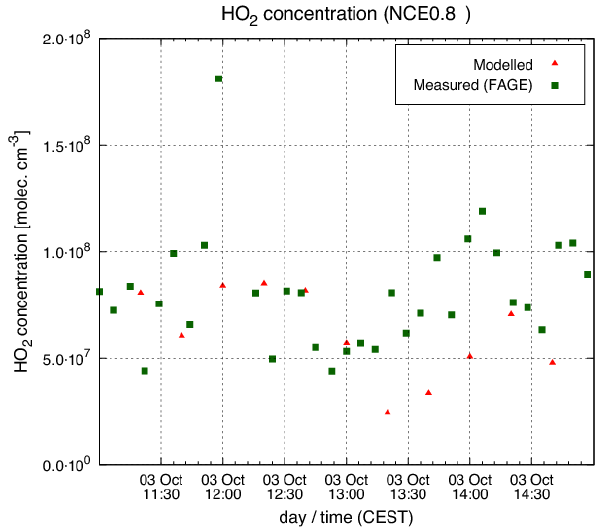
Figure 9. Comparison of the measured (green squares) and modelled (red triangles) gas-phase HO 2 concentrations at the Mt Schmücke site during non-cloud event